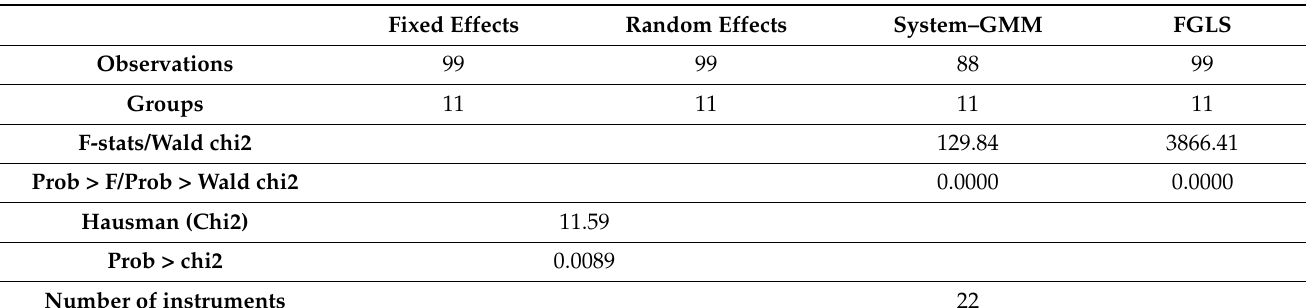
Table A2. Diagnostic tests of the data estimations on the impact of ICT adoption on stock market capitalisation.